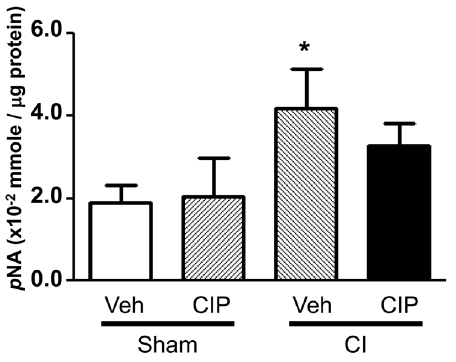
Figure 7. CIP inhibited the CI-induced increase in caspase-3 after CI. On day 1 after CI, ileal samples were collected from surviving mice and total cell lysates were prepared for detection of caspase-3 activity. Data is presented by the levels equivalent to p -nitroaniline ( p NA). n=6 per group; * p , 0.05 vs. sham-Veh, sham-CIP, and CI + CIP. CI: combined injury; CIP: ciprofloxacin; Veh: vehicle.